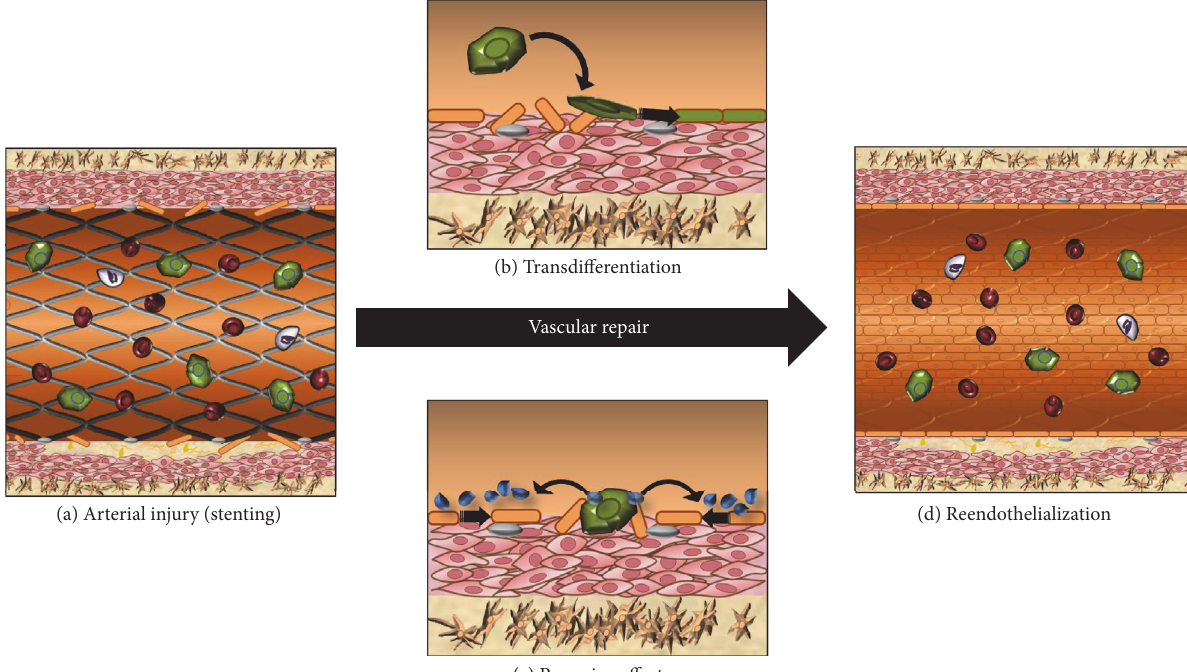
Figure 1: Mechanisms of EPC-mediated vascular repair: (a) coronary stenting resulting in arterial injury. Placement of coronary stent to treat obstructive coronary artery disease (CAD) with plaque being pushed into vessel wall and denudation of endothelial cells (ECs) causing vascular injury. Circulating EPCs then home to the site of vascular injury and mediate repair via either transdifferentiation or paracrine effects. (b) Transdifferentiation of EPCs: EPC transdifferentiates into ECs (black arrows) to repair denuded endothelium. (c) Paracrine effects of EPCs: EPCs secrete numerous chemokines (blue) which stimulate surrounding cells to proliferate and migrate towards site of injury to regenerate the EC layer (black arrows). (d) Reendothelialization: endothelial layer is restored with coronary stent underlying regenerated EC layer. Adventitia (brown), media (pink), endothelial cells (orange), EPCs (green), erythrocytes (red), and leukocytes (white).